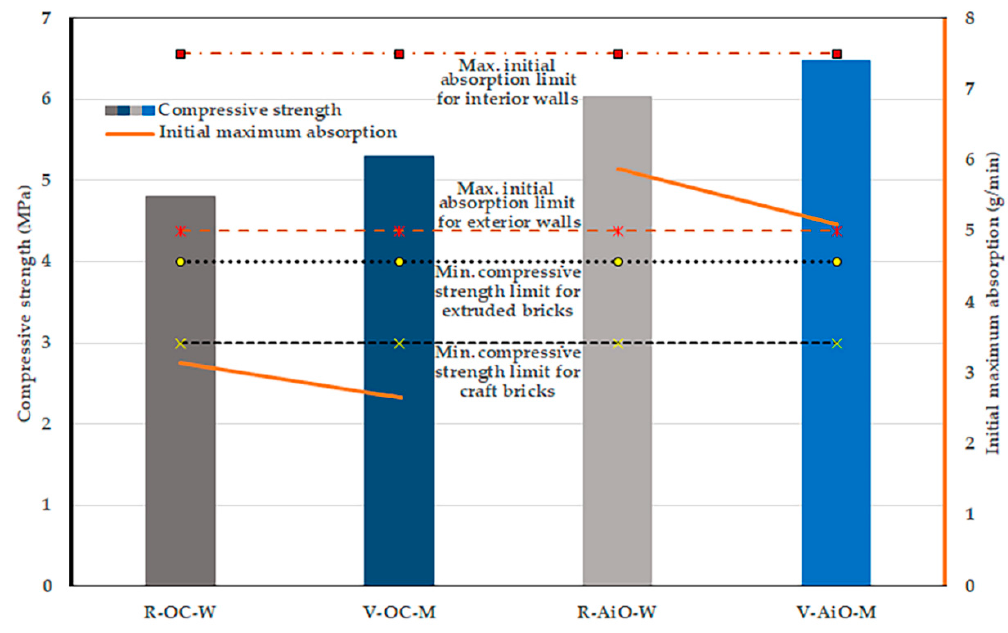
Figure 6. Compressive strength and initial maximum absorption values.